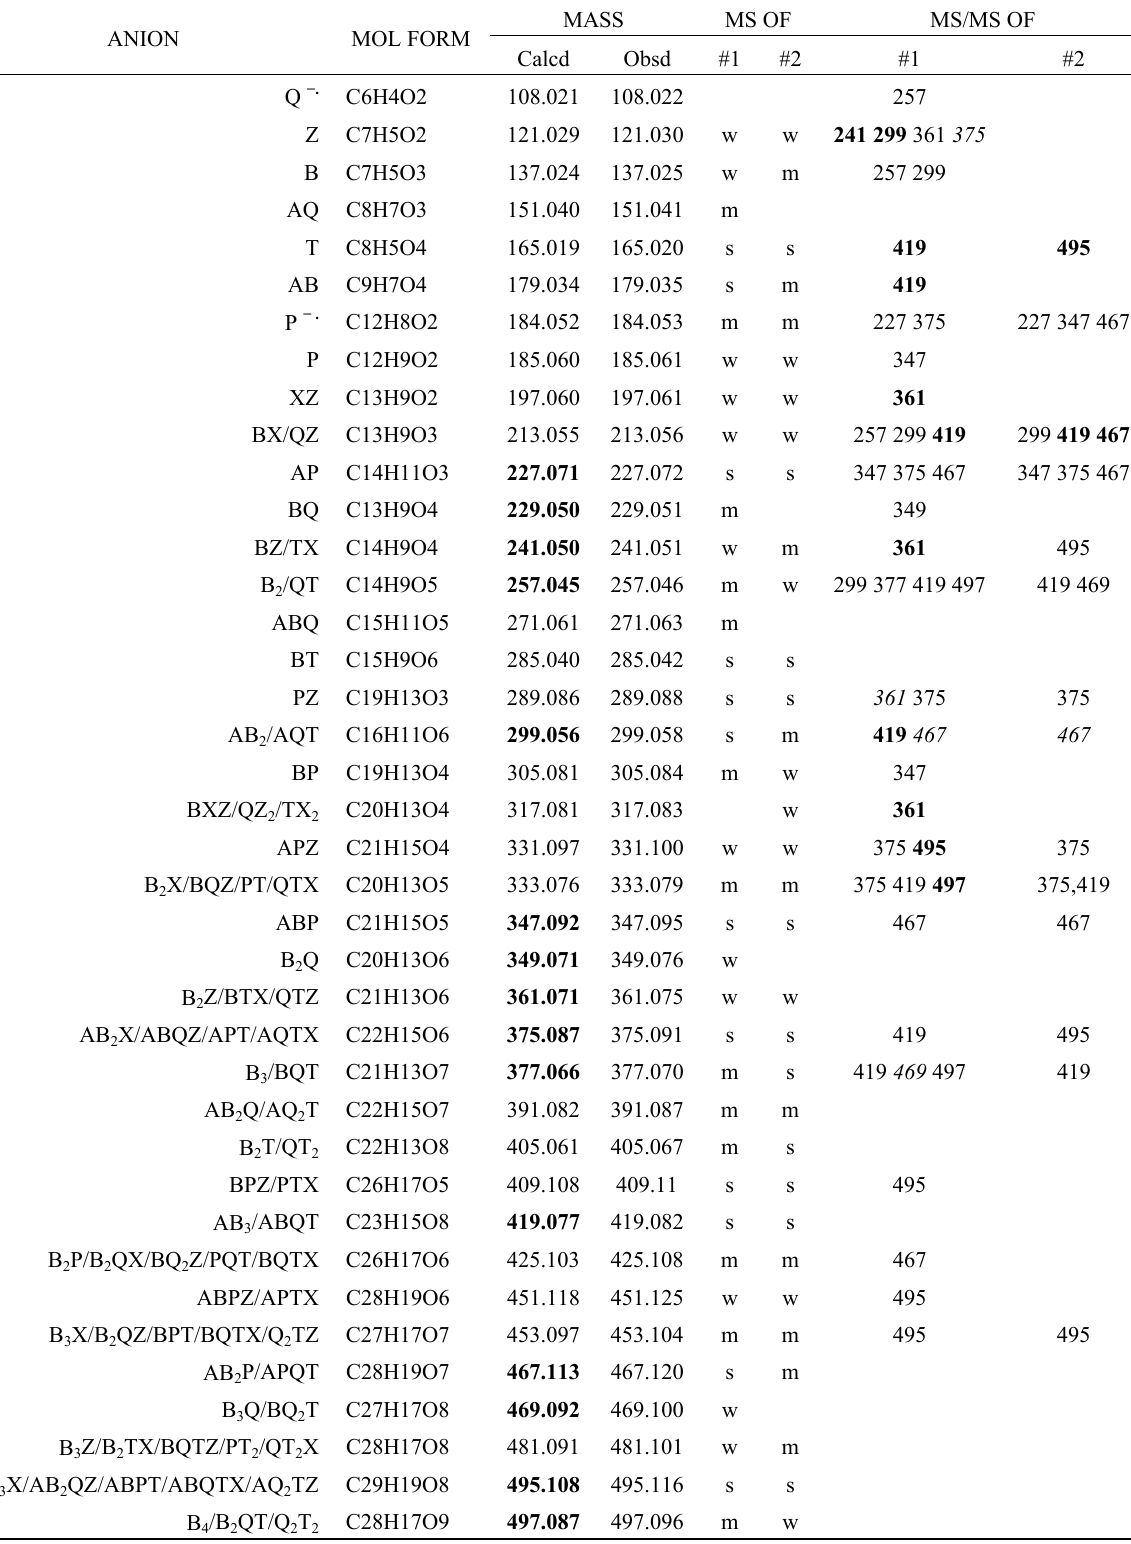
Table 3. Molecular formulas of MS and MS/MS peaks observed from prepolymers 1 and 2 by ESI − . Boldface calculated masses = MS/MS was performed; boldface MS/MS masses can come from anhydrides but not esters; italicized MS/MS masses, see text; s = strong, m = medium, w =